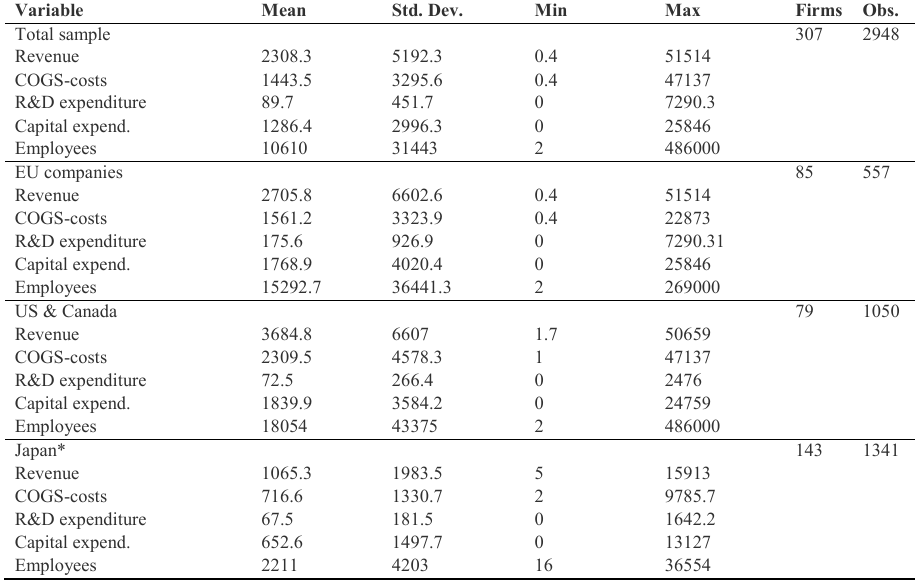
Table 1 Descriptive statistics of main variables Variable